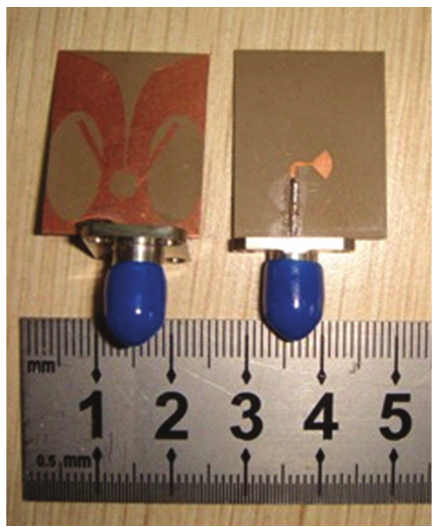
Figure 4: View of the fabricated stealth antenna.